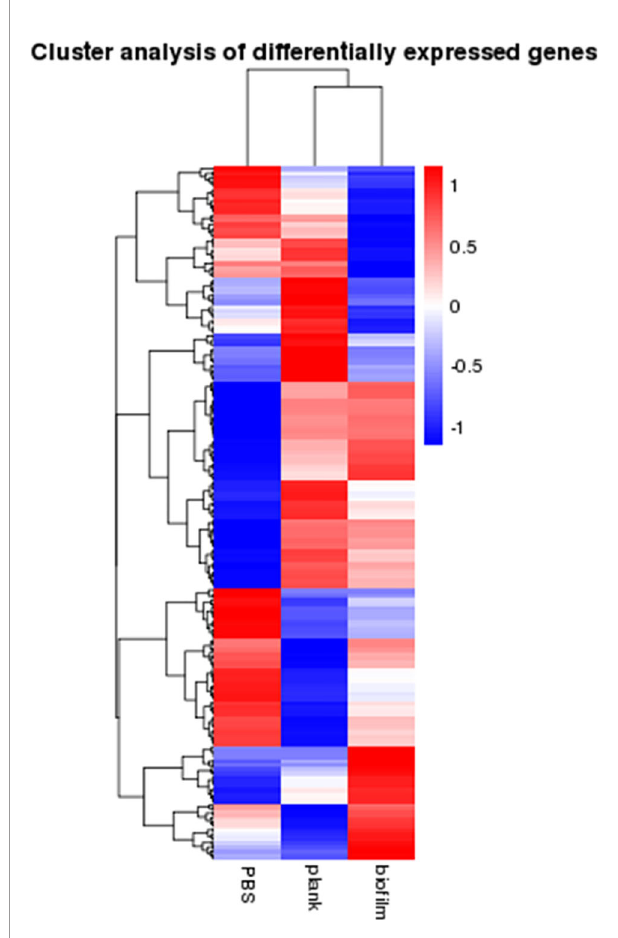
FIGURE 3 | Cluster analysis of gene expression differences. The heatmap analysis of gene expression differences between the PBS, plank, and bio fi lm groups. Weak and strong correlations between variables are shown in green and red, respectively.